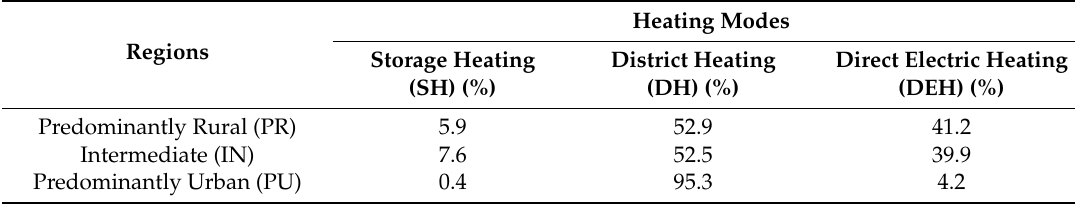
Table 1. Heating mode distributions dependent on different